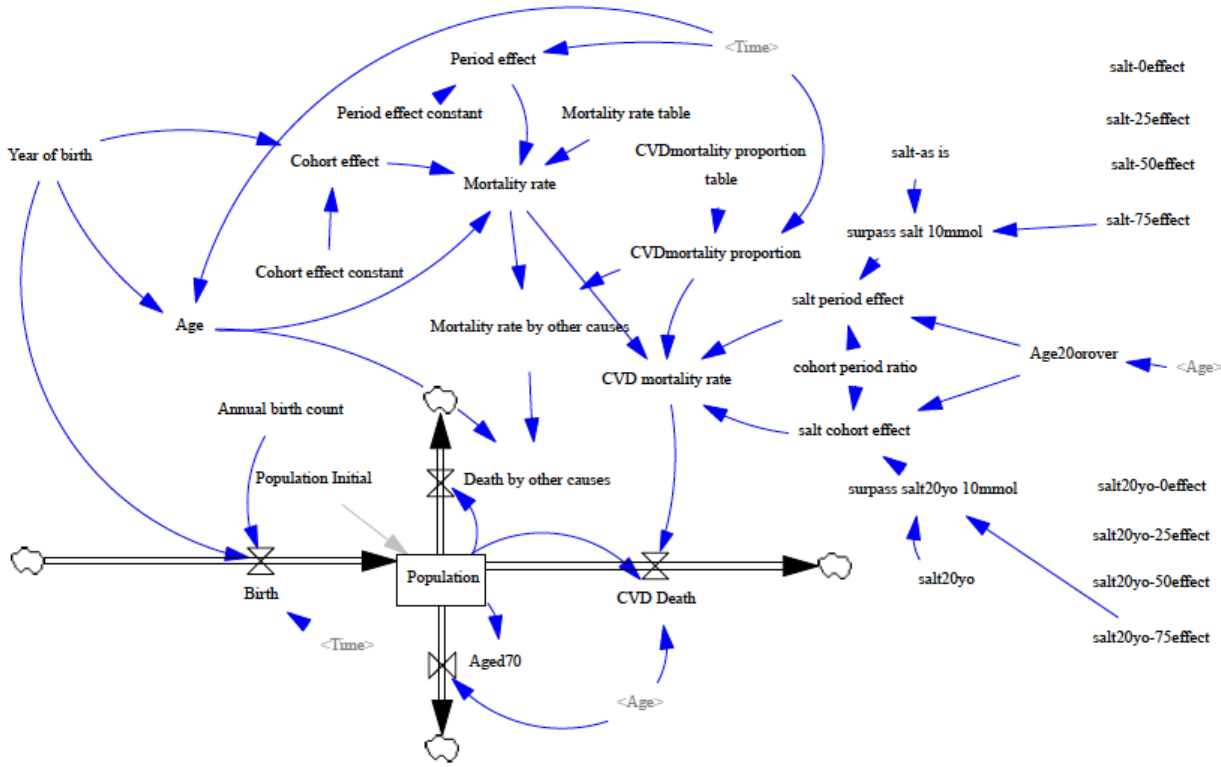
Figure 1. System dynamics model of the age–period–cohort effects of dietary salt intake on cardio- vascular mortality in the Japanese adult population aged 20 to 69 years between 1950 and 2017.